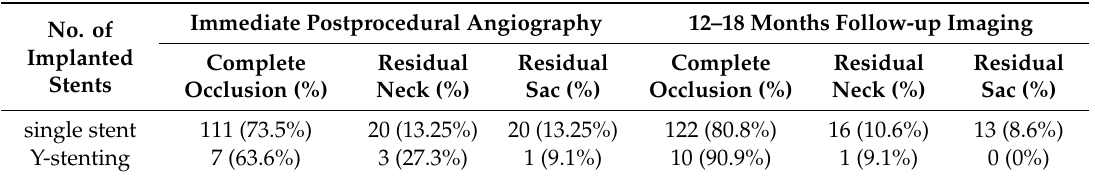
Table 4. Aneurysm occlusion rate stratified by number of implanted